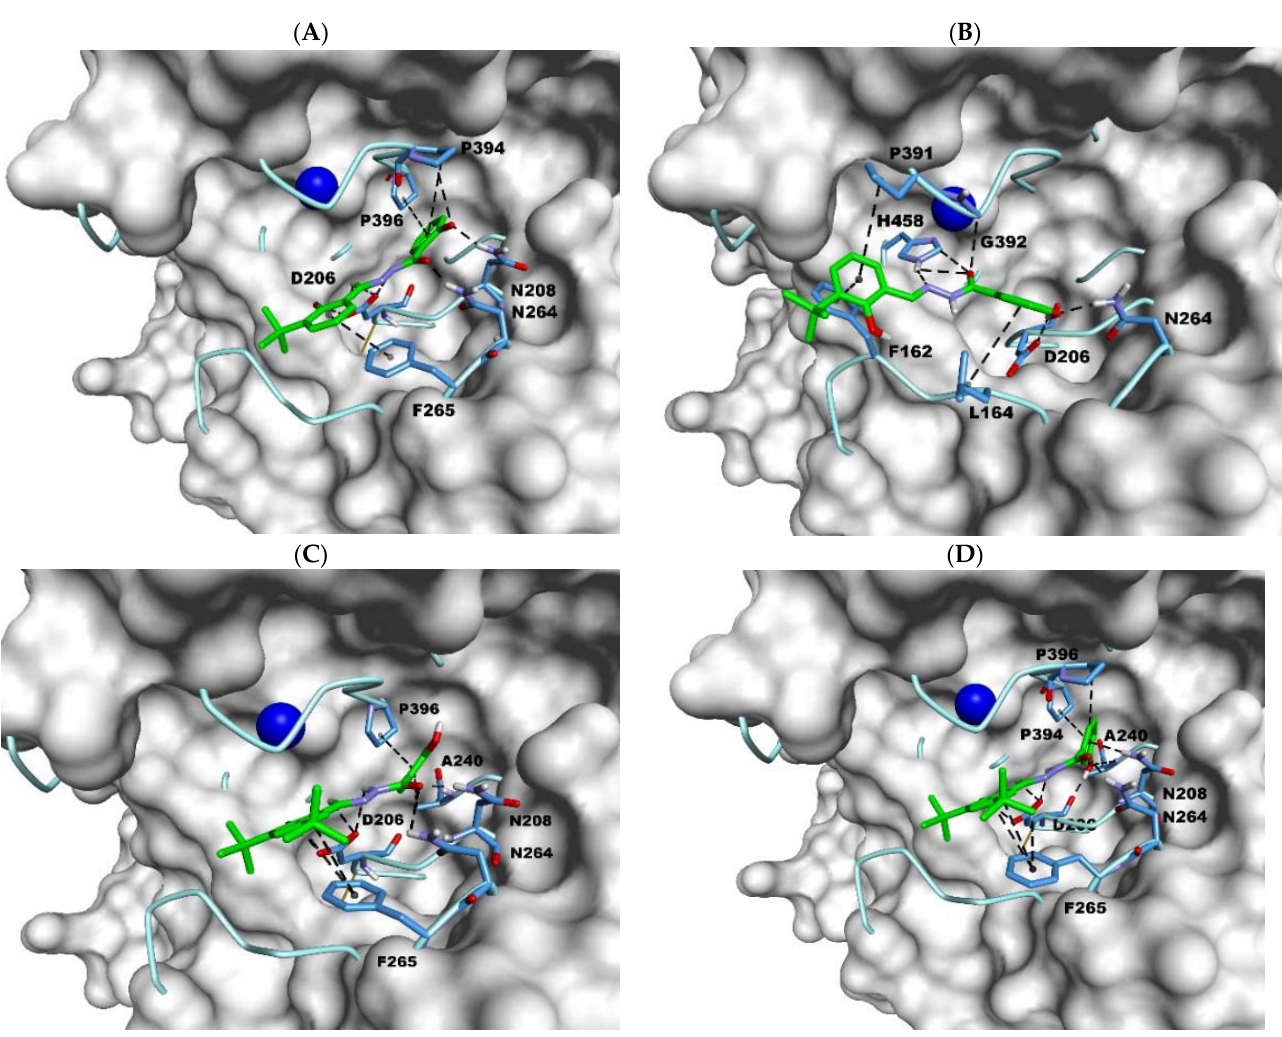
Figure 9. The active center of the laccase (PDB: 1GYC) with the interaction between selected amino acid and inhibitors: 4j ( A ), 4k ( B ), 4g ( C ), 4h ( D ). The amino acids are shown as blue sticks and the protein is shown as a light blue tube, and its surface is colored gray. The Cu ion is shown as a blue sphere. The interactions are black dashed lines.